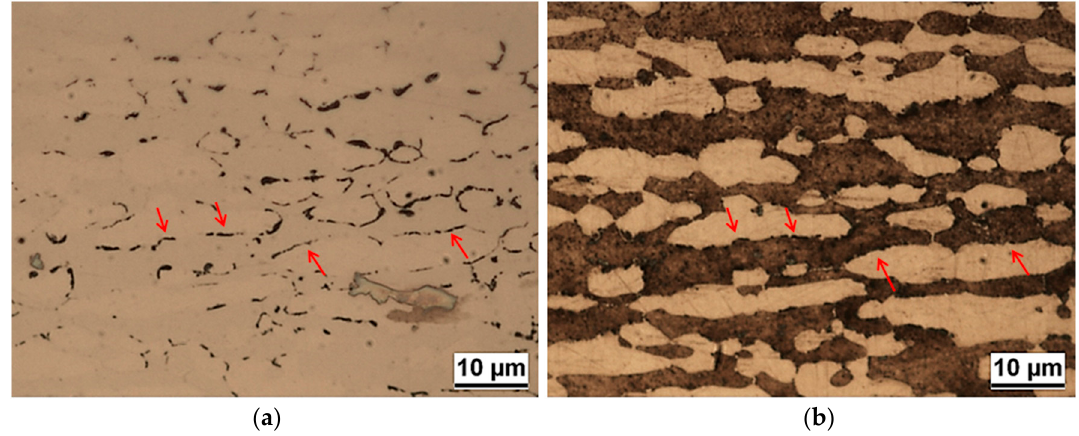
Figure 7 . Micrograph of LDSS 2404 electrode aged for 60 min at 850 °C, after CPT test in 0.1 M NaCl solution before ( a ) and after etching ( b ) with Beraha’s reagent.